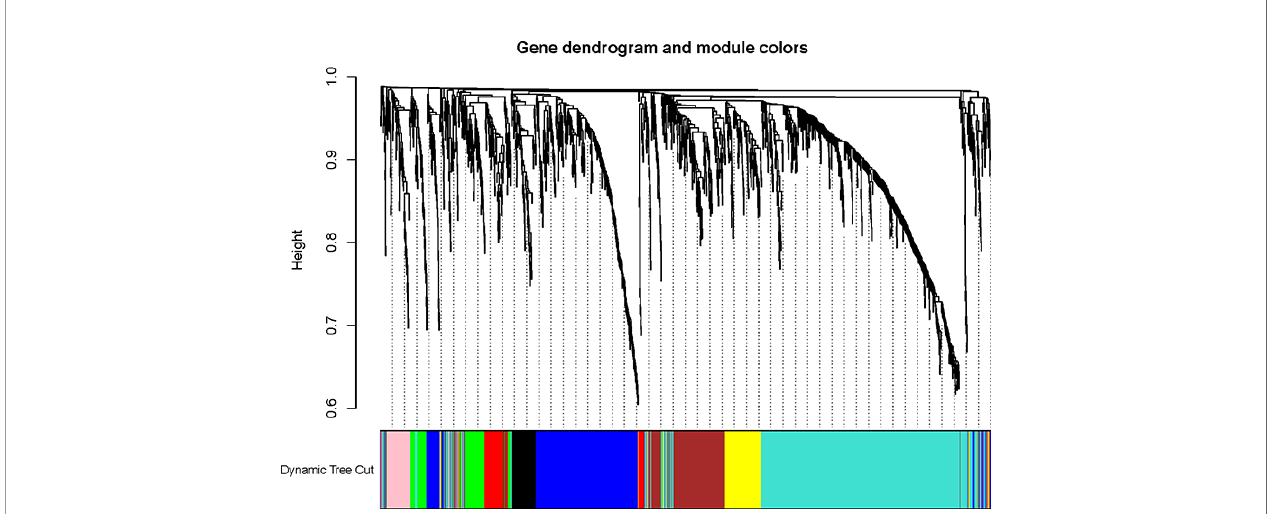
FIGURE 3 | The Cluster dendrogram of co-expression network modules was ordered by a hierarchical clustering of genes based on the 1-TOM matrix. Each module was assigned to different colors.